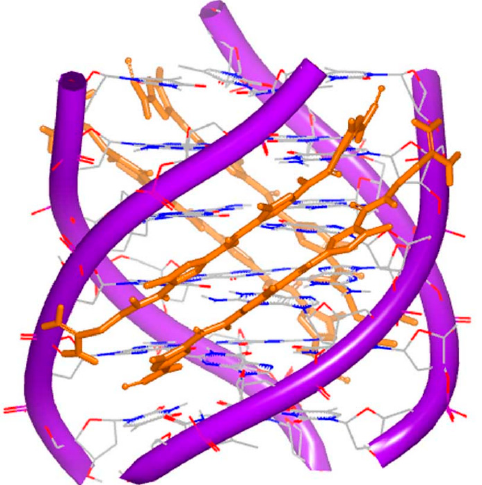
Figure 18. Complex of a DNA quadruplex with distamycin A (PDB code: 2JT7). The orange structure represents the small molecule; the purple structure represents the backbone of nucleic acid; the blue and red atoms in the molecule represent nitrogen and oxygen atoms, respectively.